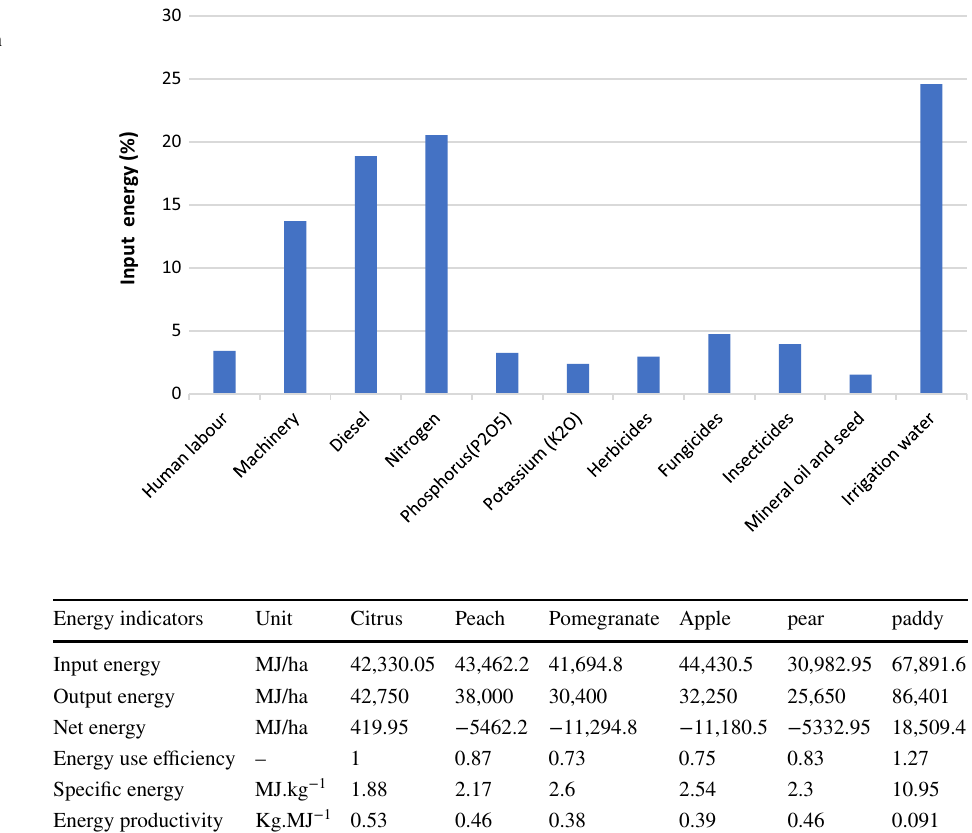
Fig. 2 Average energy inputs per parameter in the production of horticultural products in the Tajan plain (percentage)